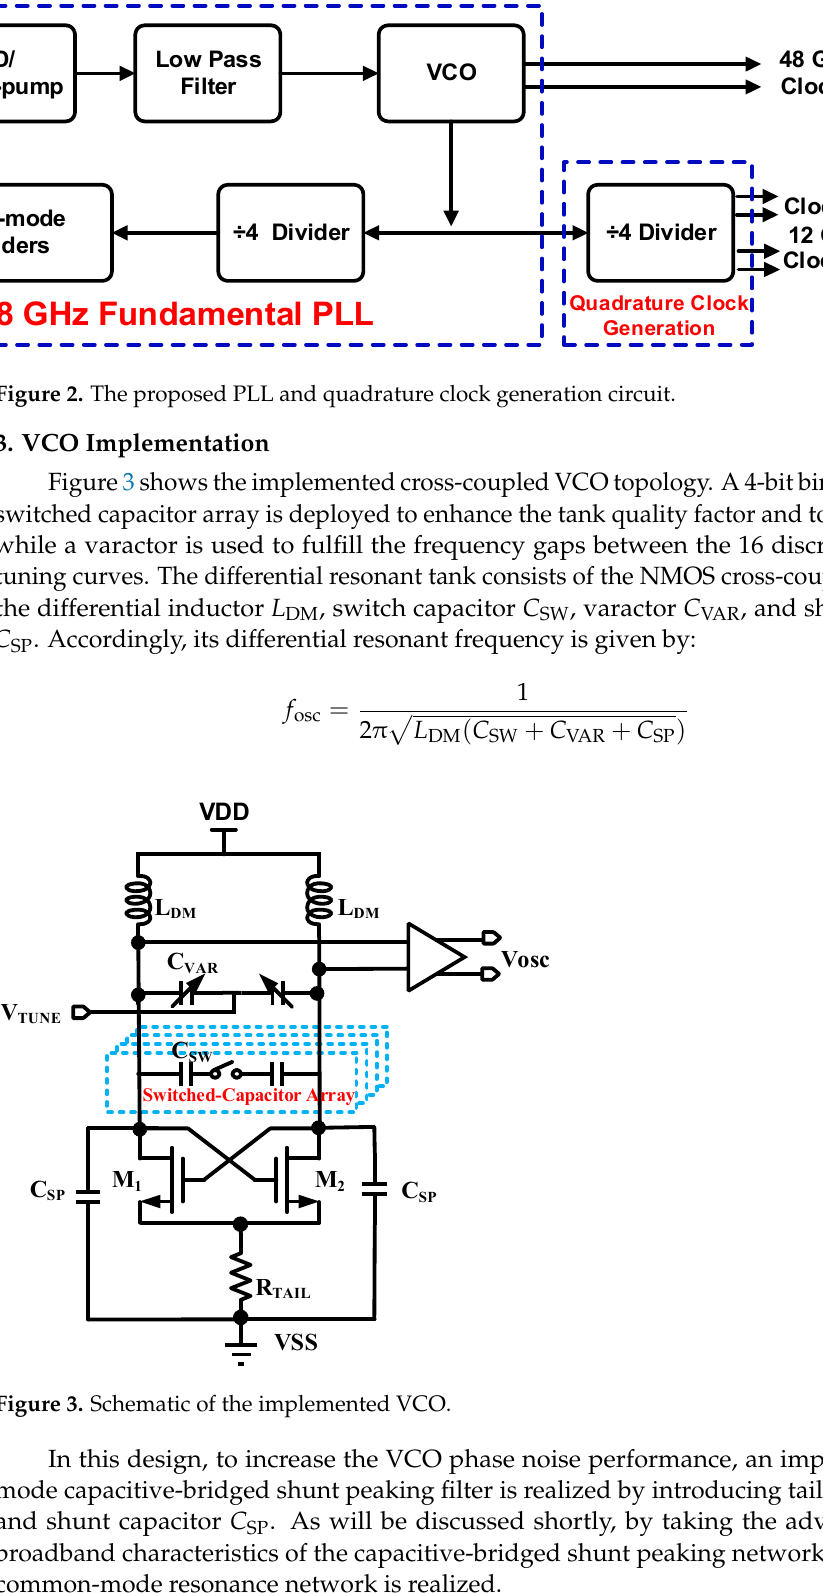
Figure 3. Schematic of the implemented VCO.